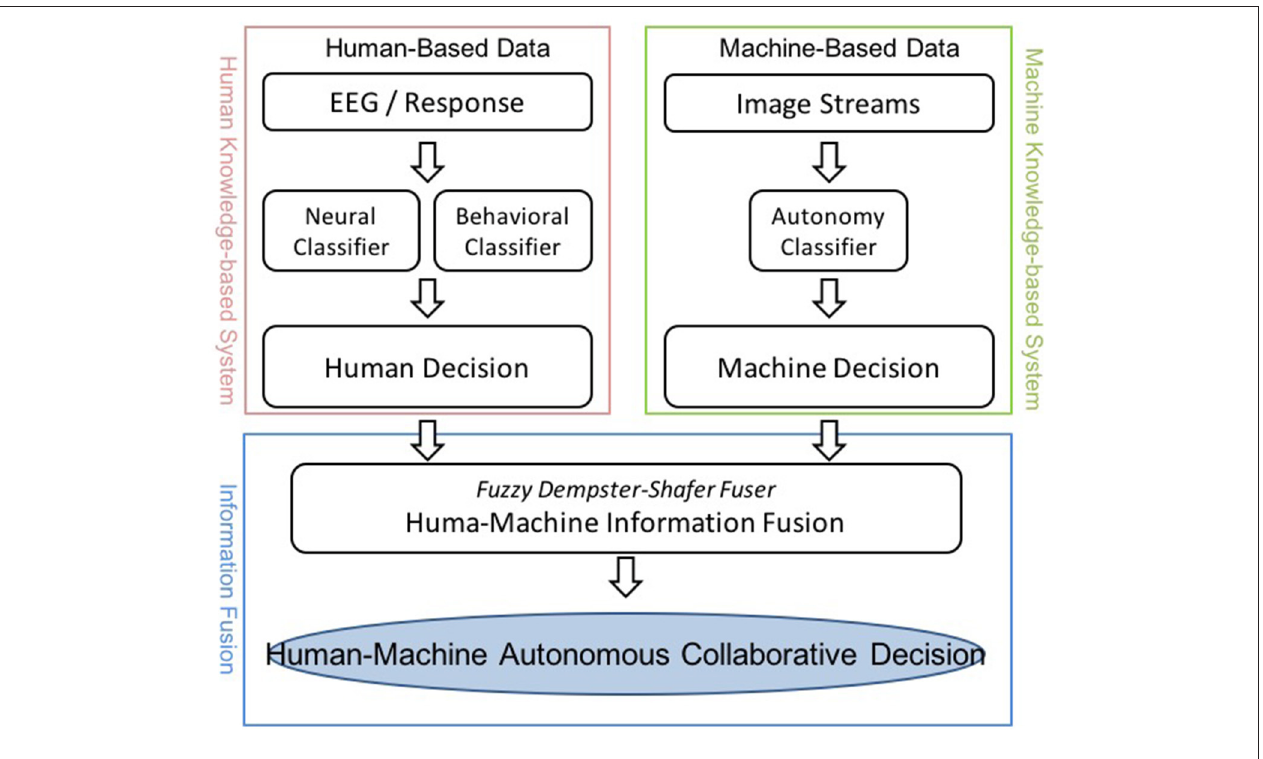
FIGURE 1 | The proposed Human-Machine Autonomous